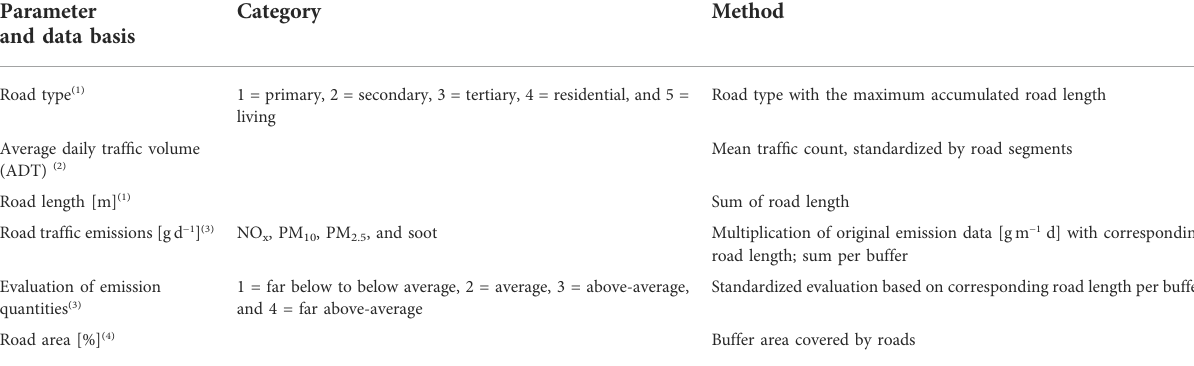
TABLE 1 Parameters derived from spatial data in combination with the four buffer radii. Data basis: Environmental Atlas Berlin, speci fi c data sets: 1) Detailnetz Berlin (SenUVK, 2017), 2) traf fi c Volume 2014 (SenStadtUm, 2017), 3) traf fi c-related emissions 2015 (SenStadtWohn, 2017), and 4) ALKIS Berlin Gebäude (SenStadtWohn,